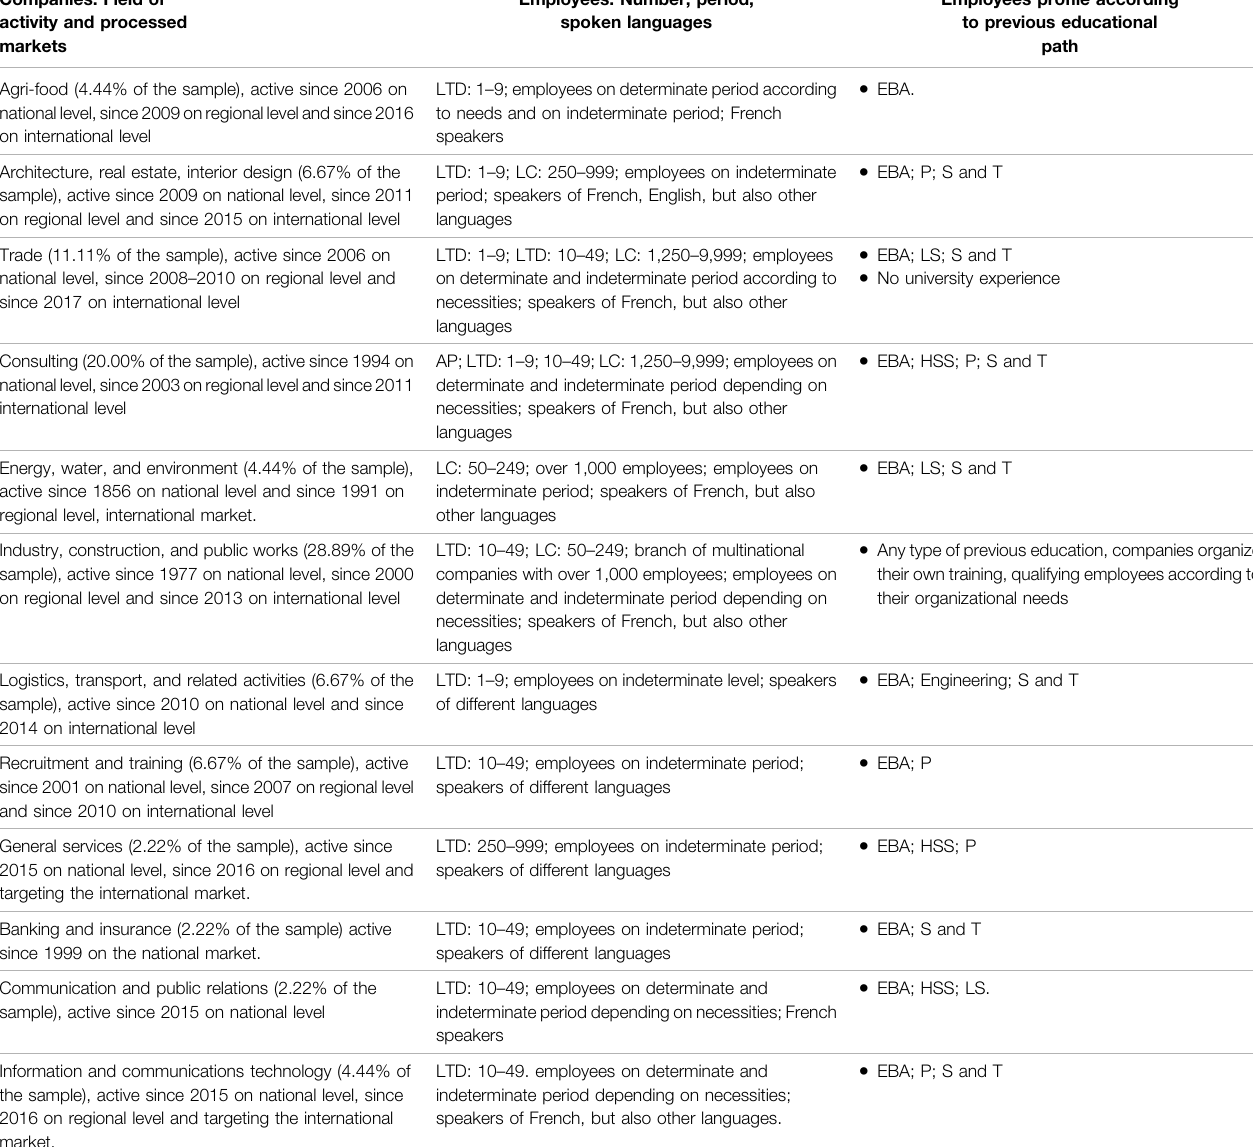
TABLE 1 | Pro fi le of